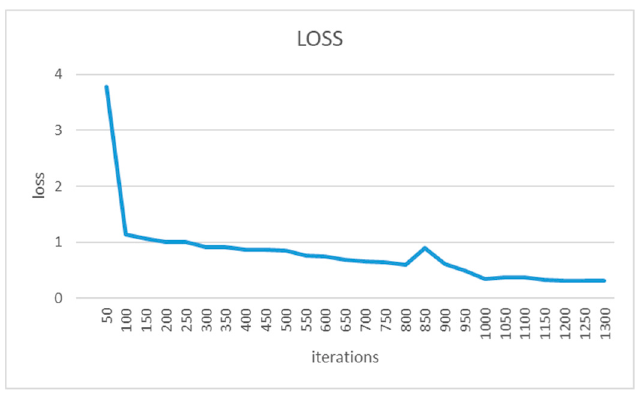
Figure 15. Loss curve.